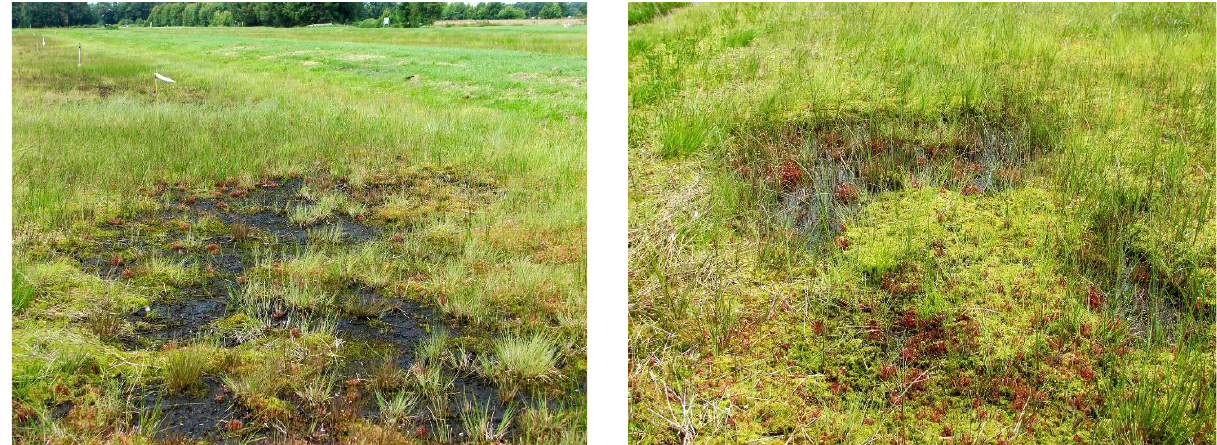
Figure 2. Open mud (left) and small open and water-covered sites with Drosera intermedia (right) on the Sphagnum papillosum field of the Sphagnum farm in Rastede (north-west Germany). Photos: Balázs Baranyai, 16 July